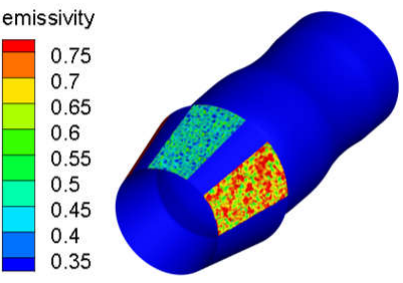
Figure 11 . Random damage of skin coating.